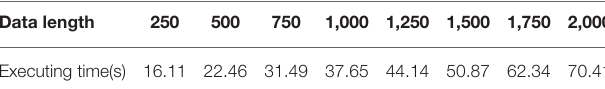
TABLE 6 | The relationship between data length and executing